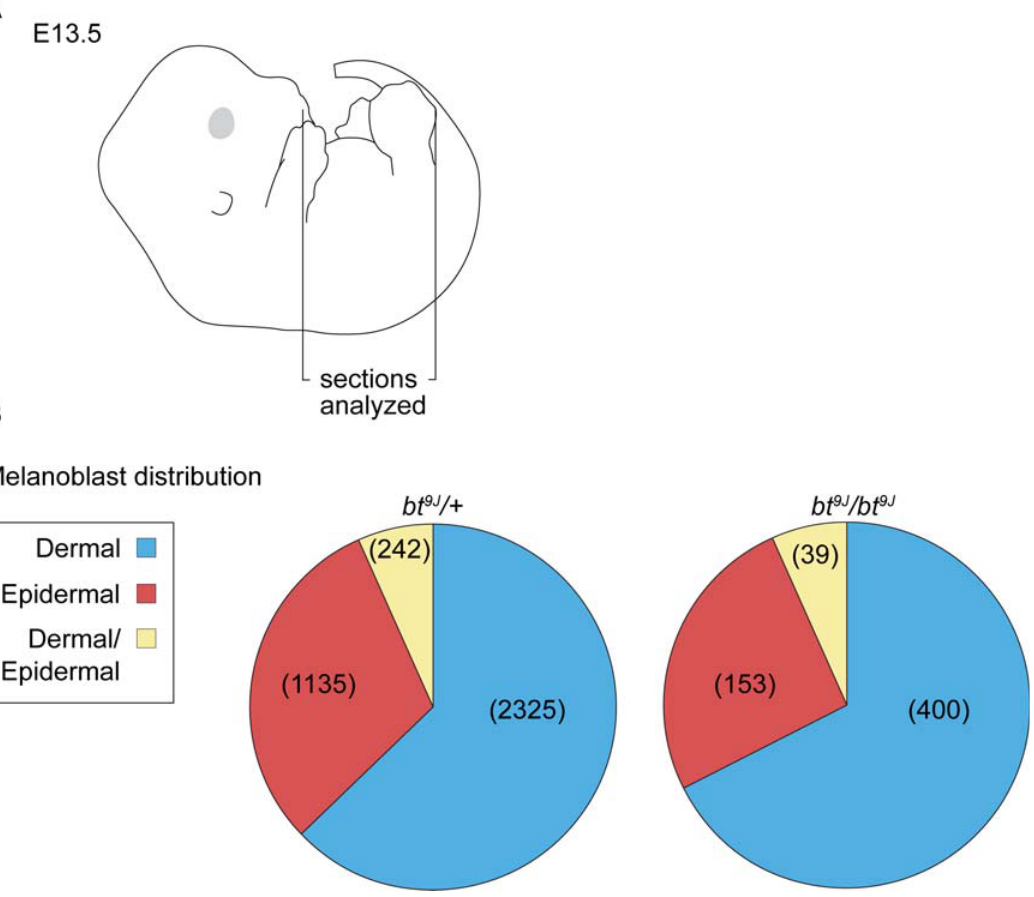
Figure 3. Melanoblast distribution in the skin layers of E13.5 bt 9J /bt 9J embryos is normal. (A) A cartoon representation of an E13.5 whole mount embryo showing the region between the fore- and hind-limbs from which 16 m m trunk sections were analyzed. (B) Pie charts representing the melanoblast distribution in the dermis (blue), epidermis (red), and dermal/epidermal border (yellow) from E13.5 bt 9J / + (top) and bt 9J /bt 9J (bottom) sections with the total number of melanoblasts indicated in parentheses (n=2 embryos, each genotype). There was no significant difference in melanoblast distribution between bt 9J / + and bt 9J /bt 9J embryos (p=0.056). doi:10.1371/journal.pgen.1000003.g003 PLoS Genetics |